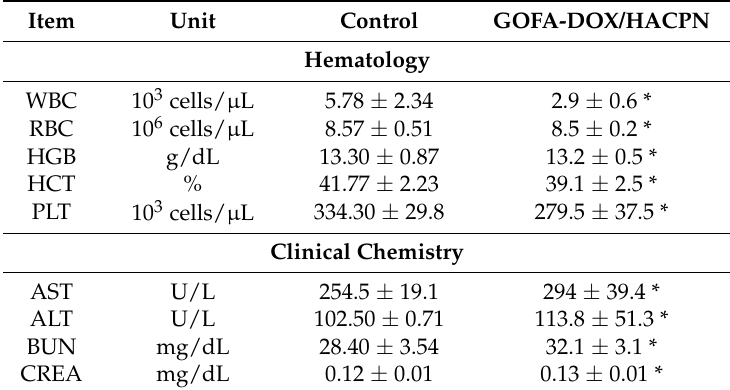
Table 1. Blood analysis for evaluation of systemic